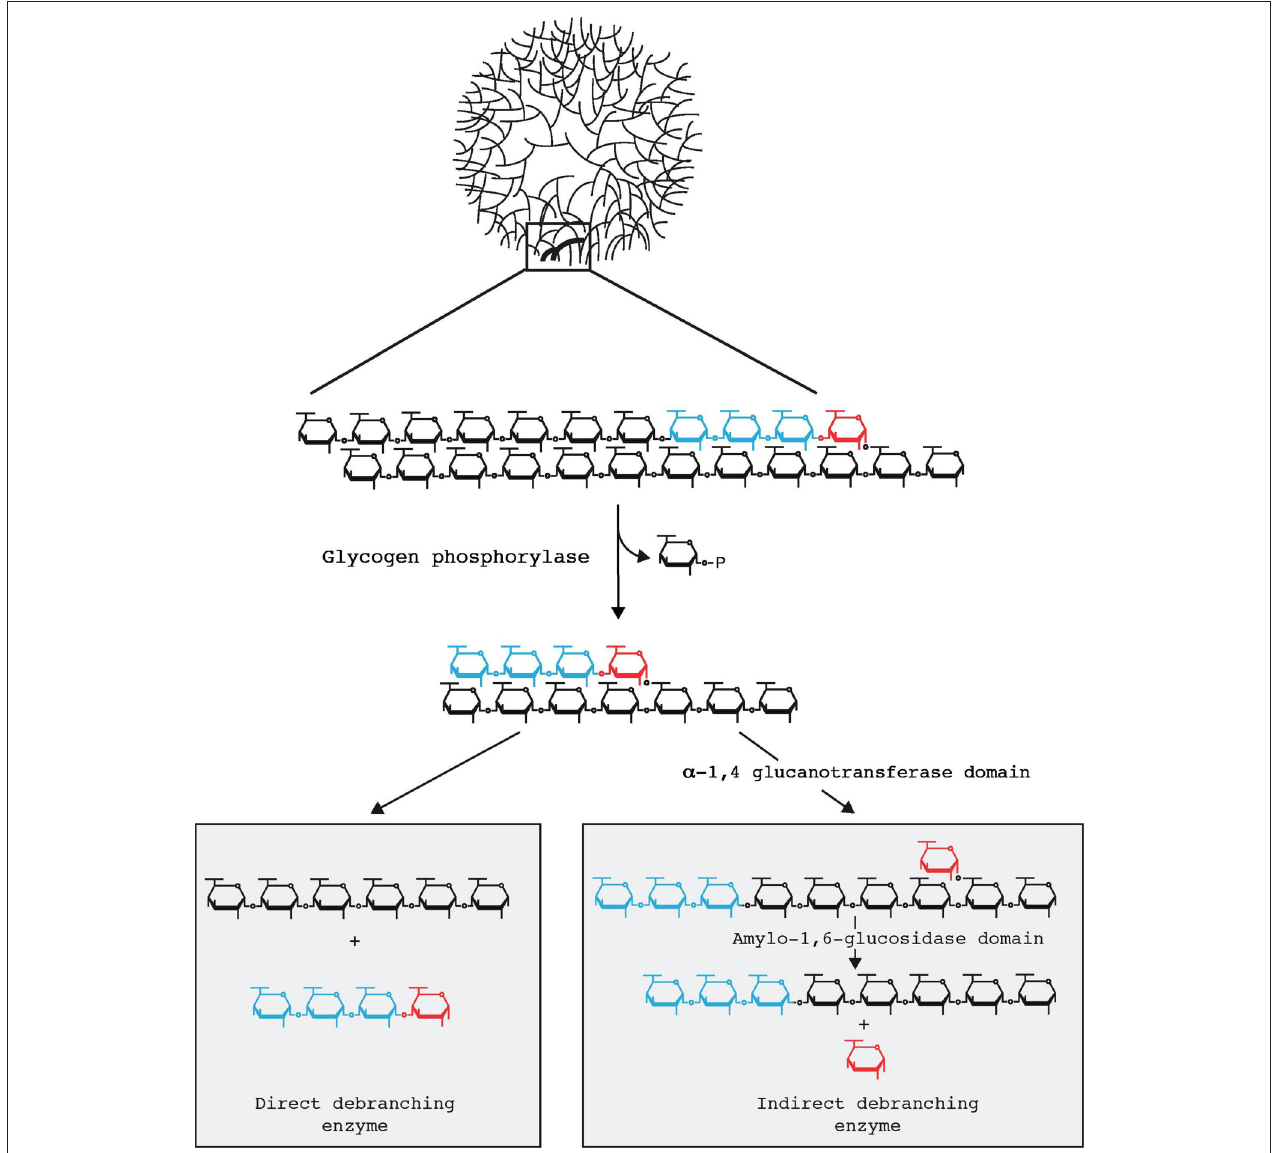
FIGURE 1 | Glycogen particle debranching in eukaryotes and bacteria. A 40nm diameter hydrosoluble glycogen particle is displayed on top emphasizing the outer chains connected to the particle through a single α -1,6 linkage. One-third in weight of the total glucose resides are these outer chains which are directly available to the hydrosoluble enzymes involved in glycogen breakdown. In both bacteria and eukaryotes these outer chains enlarged in the top panel are first recessed through glycogen phosphorylase which in the presence of orthophosphate releases glucose-1-P. All reported glycogen phosphorylases stop at a four glucose residue distance from the first encountered α -1,6 branch (displayed in red). Bacteria and eukaryotes differ at the subsequent steps (Cenci et al., 2014). Bacteria directly hydrolyse the remaining outer α -1,6 linkage through the so-called direct debranching enzyme (DBE) generating a smaller glycogen particle and releasing a small chain of four glucose residues (maltotetraose) in the cytosol. Bacteria must then metabolize these small chains and do so with the help of MOS metabolism enzymes. DBE belongs to the GH13 glycosyl hydrolase family. Eukaryotes first hydrolyse the α -1,4 preceding the branch and transfer the maltotriose (displayed in blue in the right panel) outer chain to the neighboring chain allowing for further digestion with glycogen phosphorylase. The α -1,6 linked glucose at the remaining branch is then hydrolyzed by a second active site on the same enzyme named indirect debranching enzyme (iDBE) releasing glucose which is phosphorylated to glucose-6-P by hexokinase. No MOS is released in the cytosol of eukaryotes through glycogen metabolism. iDBE is derived from a gene fusion between a GH13 and GH133 domain. Consequently one finds iDBE candidate sequences in all eukaryotes unrelated to Archaeplastida that accumulate glycogen [all opisthokonts (fungi and animals), amoebozoa, alveolata, glycogen accumulating excavata ( Trichomonas, Giardia )] whereas the fusion has never been seen in bacteria despite the extensive databases that are available (Ball et al., 2011, 2015). Bacterial GH13 DBE is likewise never seen in the aforementioned eukaryotic clades unrelated to Archaeplastida. In addition eukaryotes do not contain cytosolic enzymes of MOS metabolism with the exception of maltase (DPE2) which selectively hydrolyses maltose generated by the eukaryotic specific enzyme β -amylase.